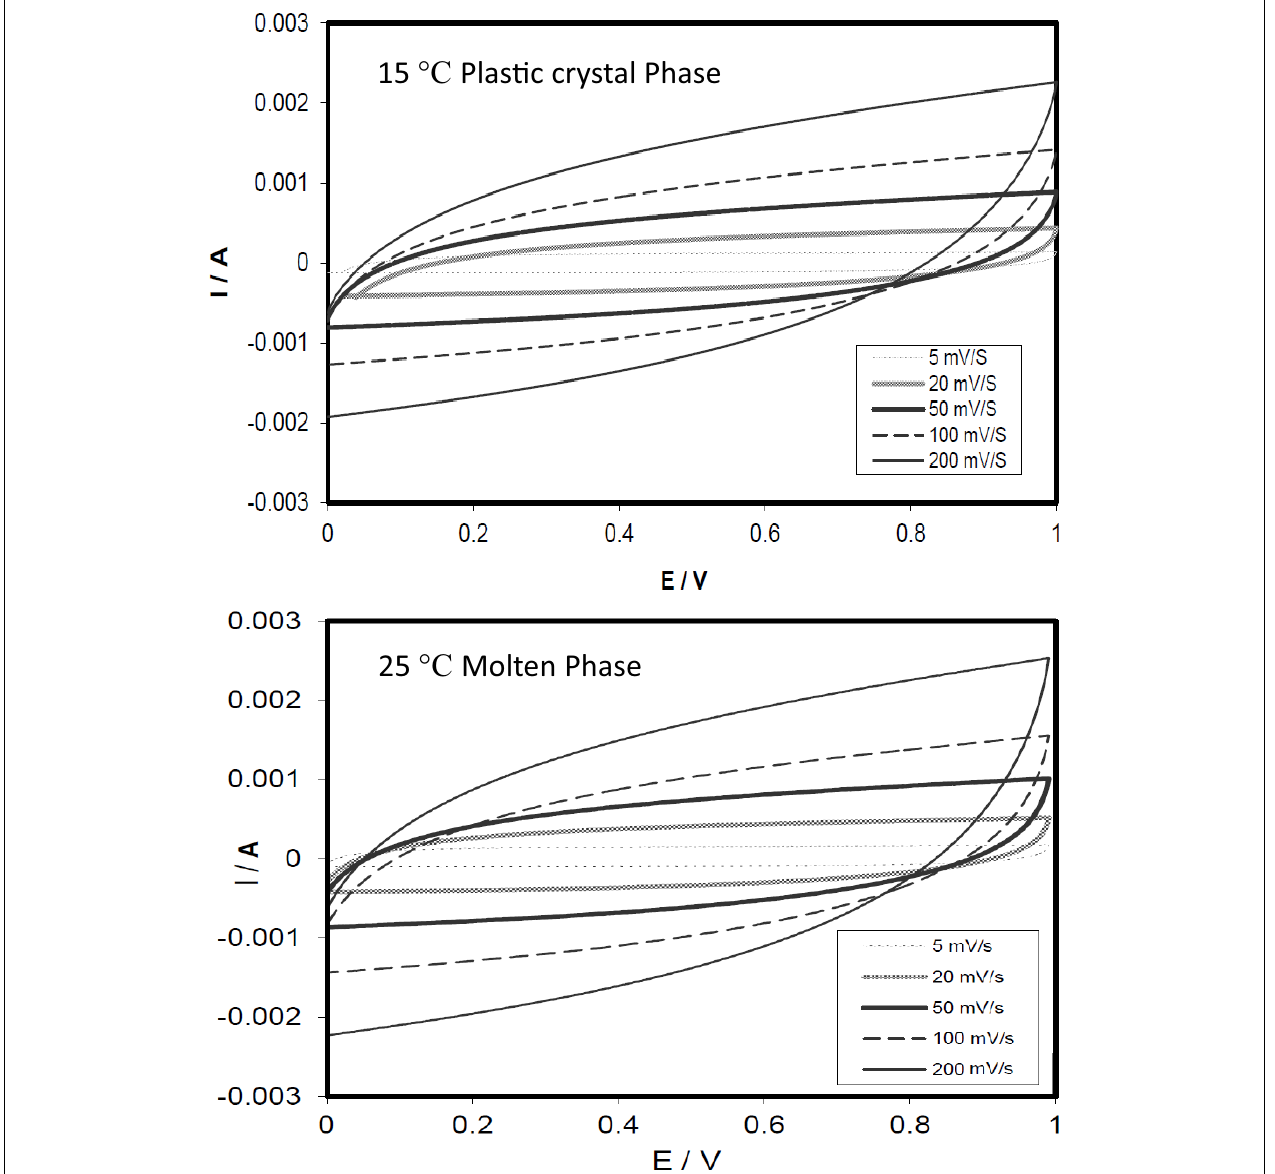
FIGURE 3 | Cyclic voltammograms at different scan rates for the EDLC utilizing the SCN-10%TBA-PF 6 in the plastic phase (15°C) and the molten state (25°C) .